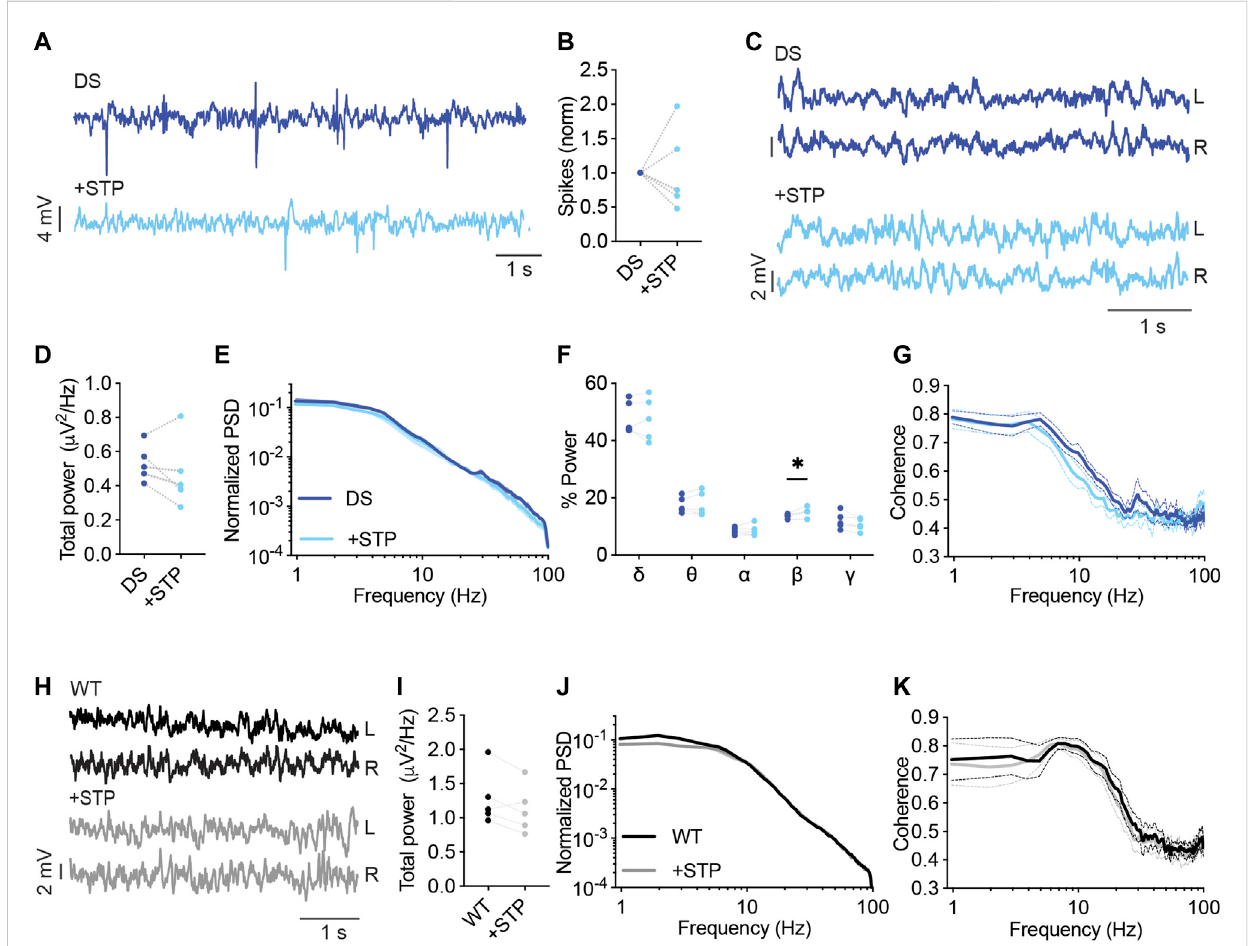
FIGURE 5 Analysis of background EcoG activity in response to STP administration. (A) Representative traces of epileptic activity in DS mice prior to and post, acute administration of STP (150 mg/kg). (B) The effect of STP on interictal spike frequency. (C) Representative traces of background ECoG in DS mice before and after STP administration. (D) The effect on total power. (E) ECoG power density pro fi les normalized to the absolute total power prior to drug administration. (F) The relative power in each frequency band. (G) Interhemispheric coherence plotted over the 1 – 100 Hz spectrum. DS, n = 5. (H) Representative traces of background ECoG from WT mice, before and after drug administration. (I) The effect of STP on total power. (J) ECoG power densitypro fi lesnormalizedtotheabsolutepowerpriortodrugadministration. (K) Interhemisphericcoherenceplottedoverthe1 – 100 Hzspectrum.WT, n = 5. * p <